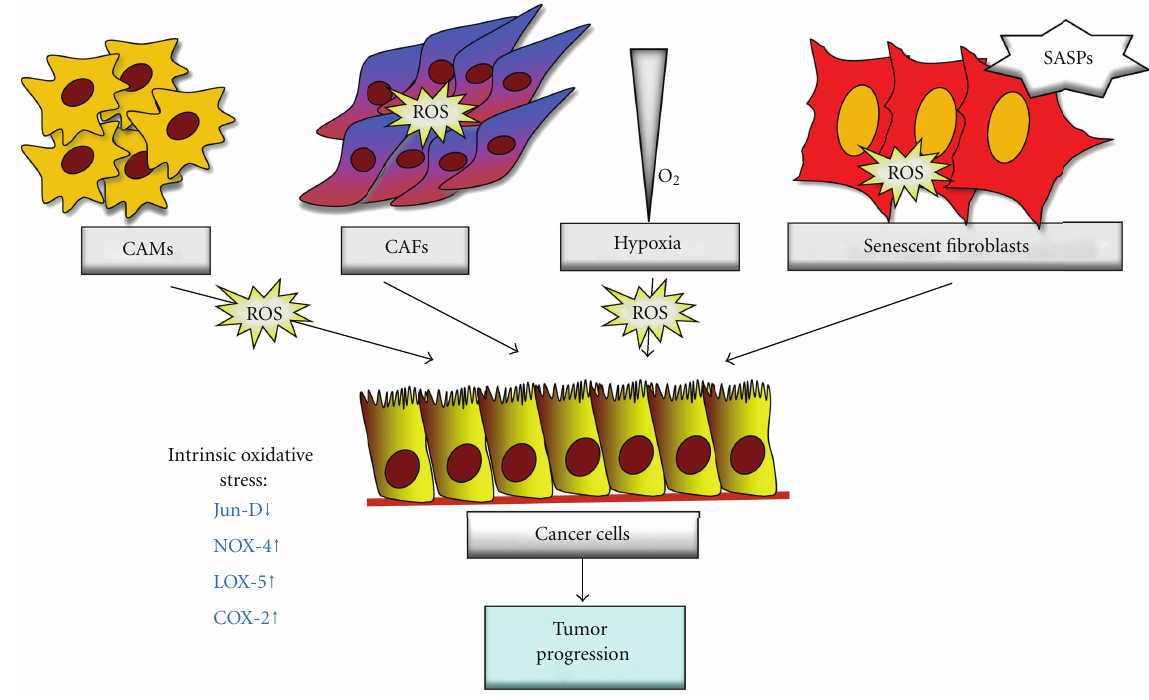
Figure 2: Oxidative stress in tumor microenvironment. Within microenvironment, oxidative stress can have intrinsic or extrinsic origin. Some stromal components can directly produce ROS. CAMs generate ROS through NOX2 activation and RNS through iNOS, while hypoxia produces oxidant species by deregulation of the complex III of mitochondrial electron transport or by NADPH oxidase activity [16, 42–46]. In response to extrinsic or intrinsic oxidative stress, CAFs became activated thus producing cytokines and proteases that a ff ect tumour progression [41, 47, 48]. In addition, microenvironment or ageing-induced oxidative stress leads to secretion of “Senescent Activated Secretory Pathway” (SASP) by senescent fibroblasts a ff ecting both stroma and cancer cells to promote cancer progression [49, 50]. Finally, cancer cells exacerbate oxidant environment by intrinsic production of oxidative stress through down-regulation of Jun D or enhanced of NOX-4, LOX-5 and COX-2 activity [41, 48,